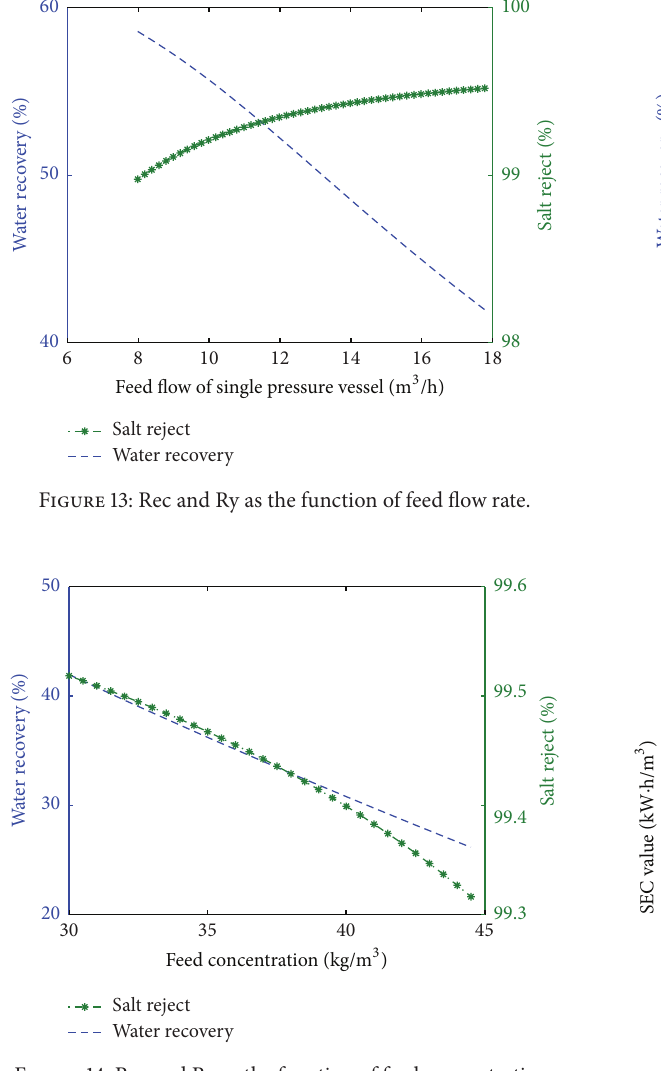
Figure 14: Rec and Ry as the function of feed concentration.